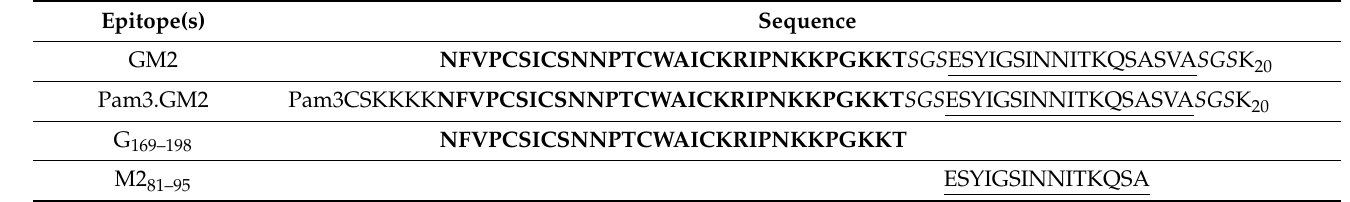
Table 1. Peptide and particle designs. Pam3CSKKKK = TLR2 ligand. G epitope residues are in bold; M2 epitope residues are underlined; SGS linker residues are italicized; K20 = poly-lysine tail. GM2 and Pam3.GM2 are designed peptides incorporated into the LbL-MP; G 169–198 and M2 81–95 peptides are used for ELISA and ELISPOT